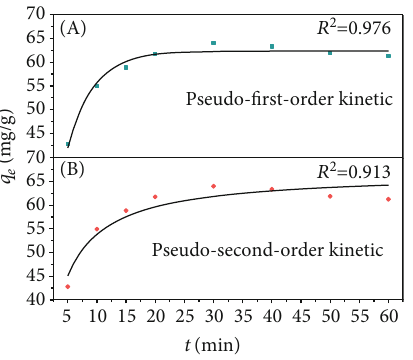
Figure 3: The fi tting curve of the (a) pseudo- fi rst-order kinetics and (b) pseudo-second-order